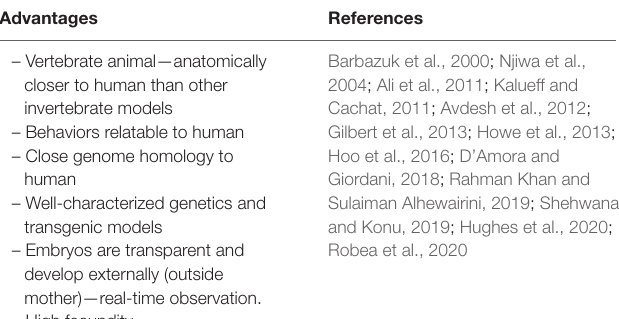
TABLE 1 | Summary of the advantages and challenges of using zebrafish as a model